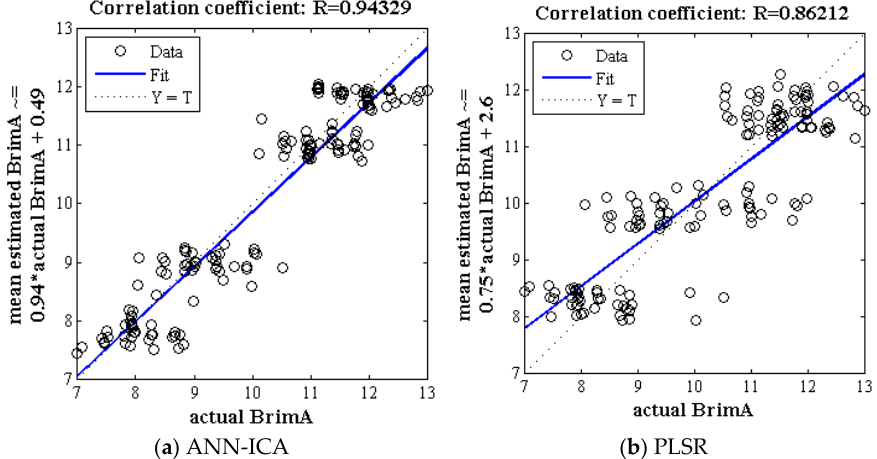
Figure 4. The correlation plot between mean predicted and true value of BrimA of Gala cultivar for classifiers of ANN-ICA and PLSR. The multiply operation is denoted by the symbol *.